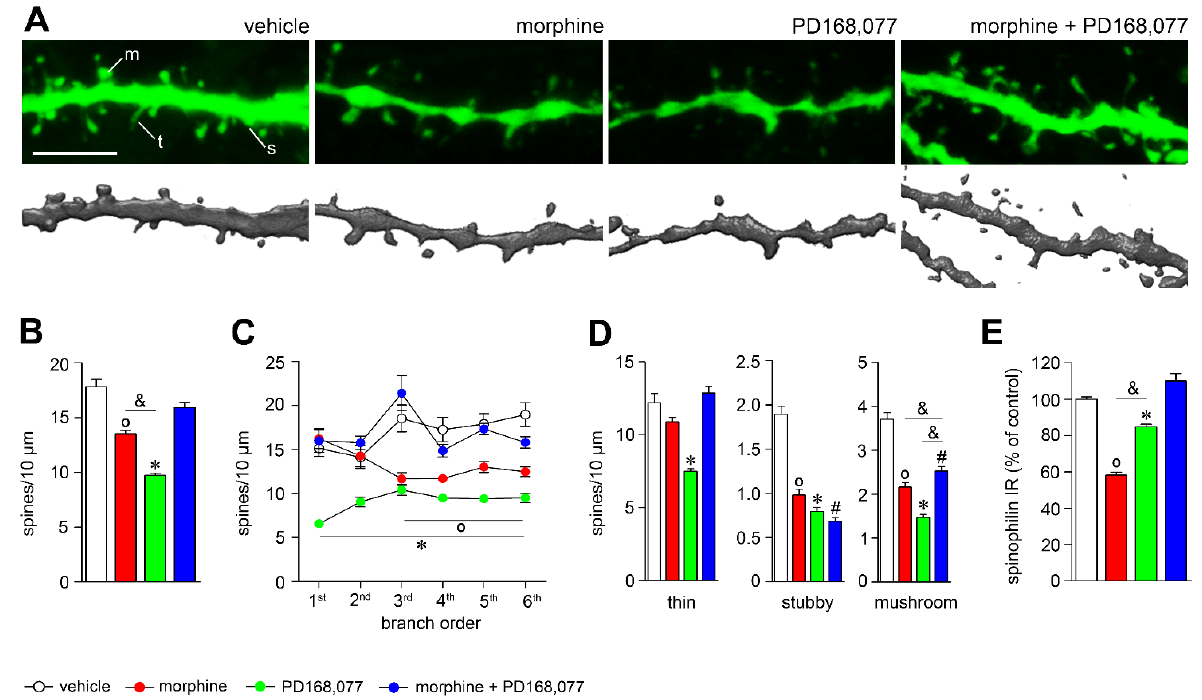
Figure 2. D 4 R activation restores spine density depletion induced by morphine. ( A ) Representative confocal images (upper panels) and reconstructions (lower panels) of dendrites showing the effect of continuous treatment (14 days) with vehicle, morphine (20 mg/kg/d), PD168,077 (1 mg/kg/d) and morphine + PD168,077 (20 mg/kg/d and 1 mg/kg/d) on spine density. ( B ) Overall spine density and ( C ) spine density as a function of dendritic branch order. ( D ) Spine density of the three classified spines (thin, stubby and mushroom) based on shape. ( E ) Histogram shows the semi-quantitative analysis of spinophilin IR in the CPu. Data represents mean ± SEM, n = 23 rats per treatment. ◦ p < 0.05 vehicle vs. morphine; * p < 0.05 vehicle vs. PD168,077; # p < 0.05 vehicle vs. morphine+PD168,077; & p < 0.05 morphine vs. PD168,077; Kruskal-Wallis test followed by Dunn’s method. Scale bar is 5 μ m. Abbreviations: m, mushroom; s, stuby; t, thin.